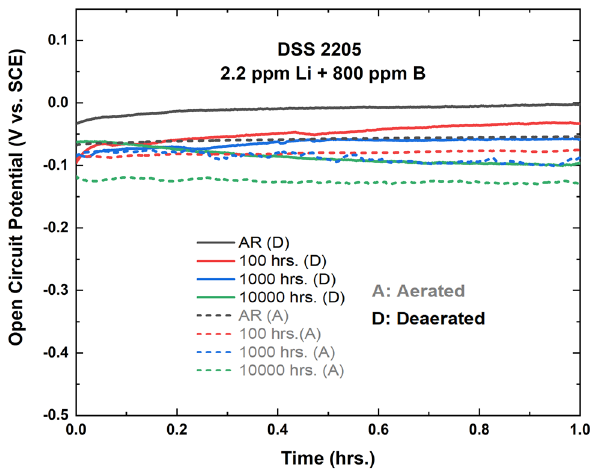
Fig. 4 Decreasing open-circuit potential values with increasing thermal aging time in the deaerated and aerated base electrolyte (2.2 ppm Li, 800 ppm